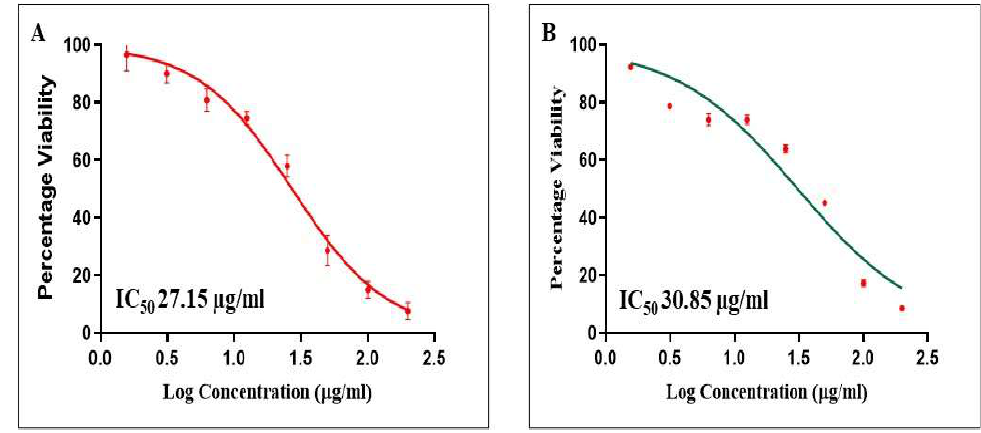
Figure 9. Cytotoxicity after 24 h of incubation with NDG ( A ); MCF-7 cells ( B ) HeLa cells with IC 50 values (µg/mL).